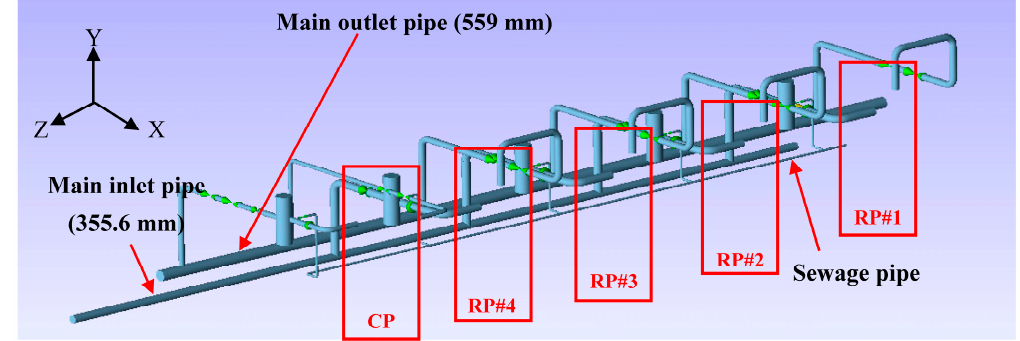
Figure 17. Overall model of the pipelines and equipment of the transmission area.